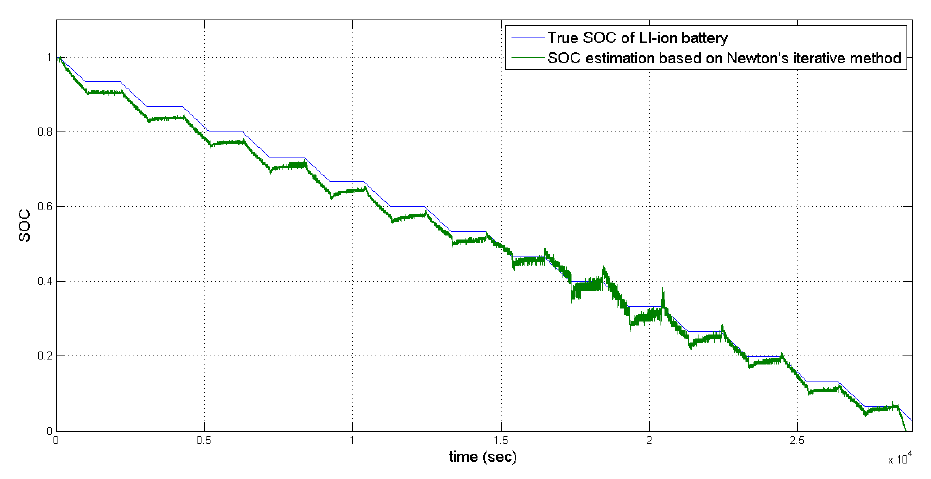
Figure 16. SOC estimation based on Newton’s iteration method.